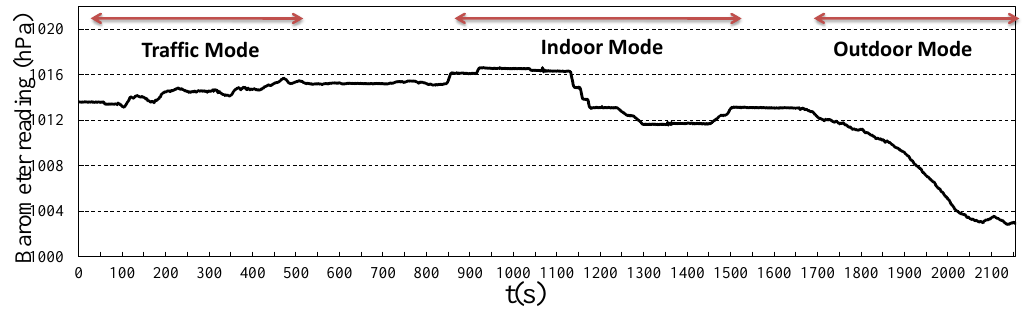
Figure 5. An example of barometer readings for different moving